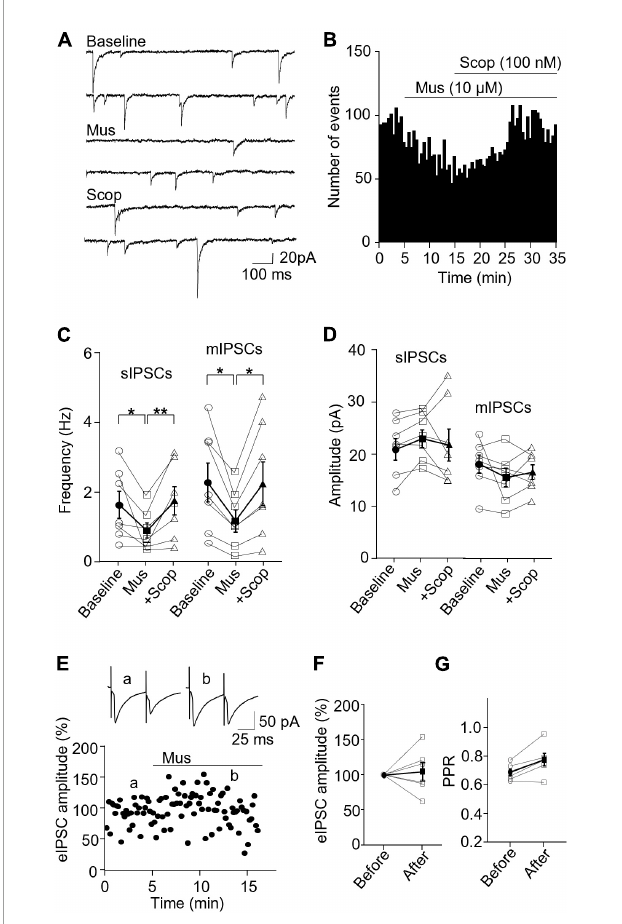
FIGURE4 Activation of mAChRs attenuates inhibitory synaptic activity in SST interneurons. (A) Representative traces of sIPSCs from an SST interneuron in the ACC before and after bath application of muscarine and scopolamine. (B) A histogram shows the effect of muscarine and scopolamine on sIPSC frequency in the SST interneurons. (C,D) Summarized data shows the effect of muscarine on sIPSC ( n =